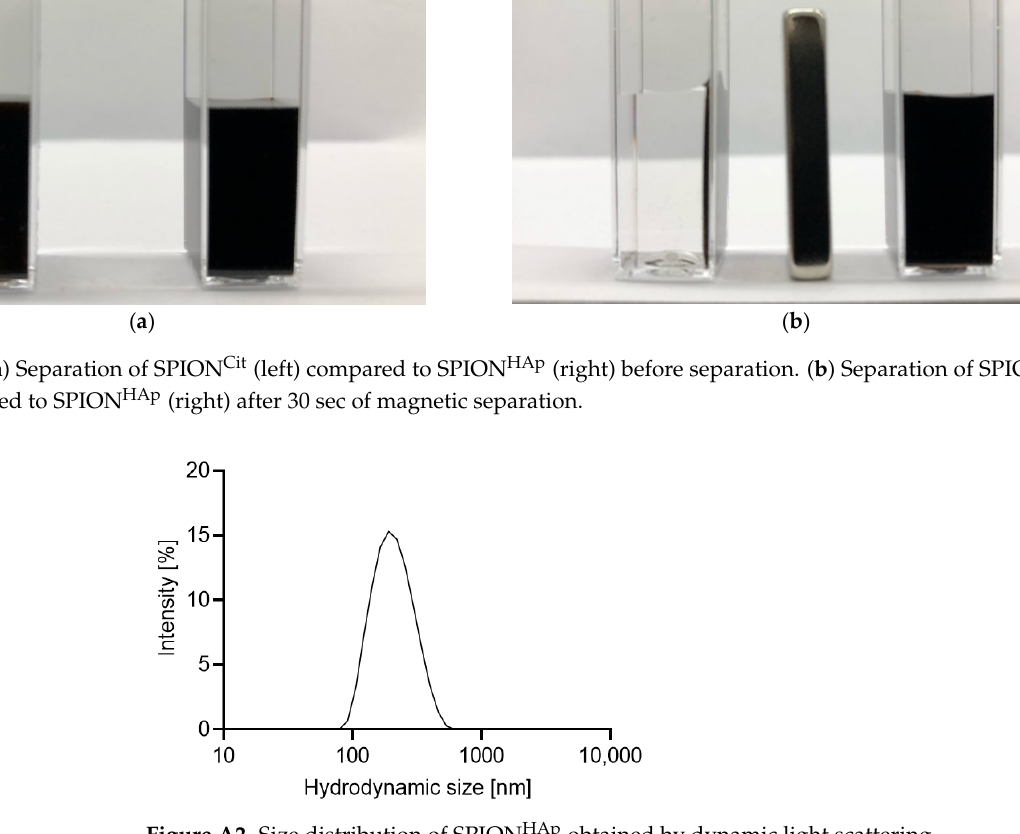
Figure A2. Size distribution of SPION HAp obtained by dynamic light scattering.